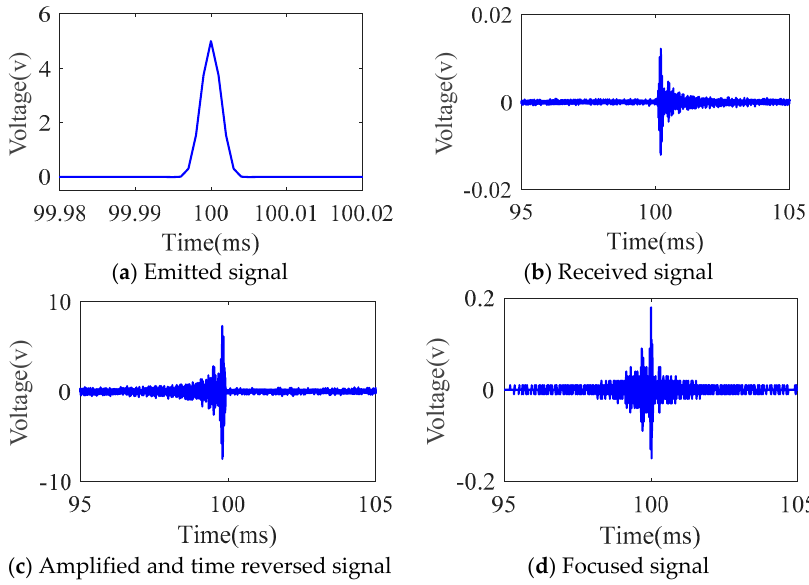
Figure 3. Illustration of time reversal process.